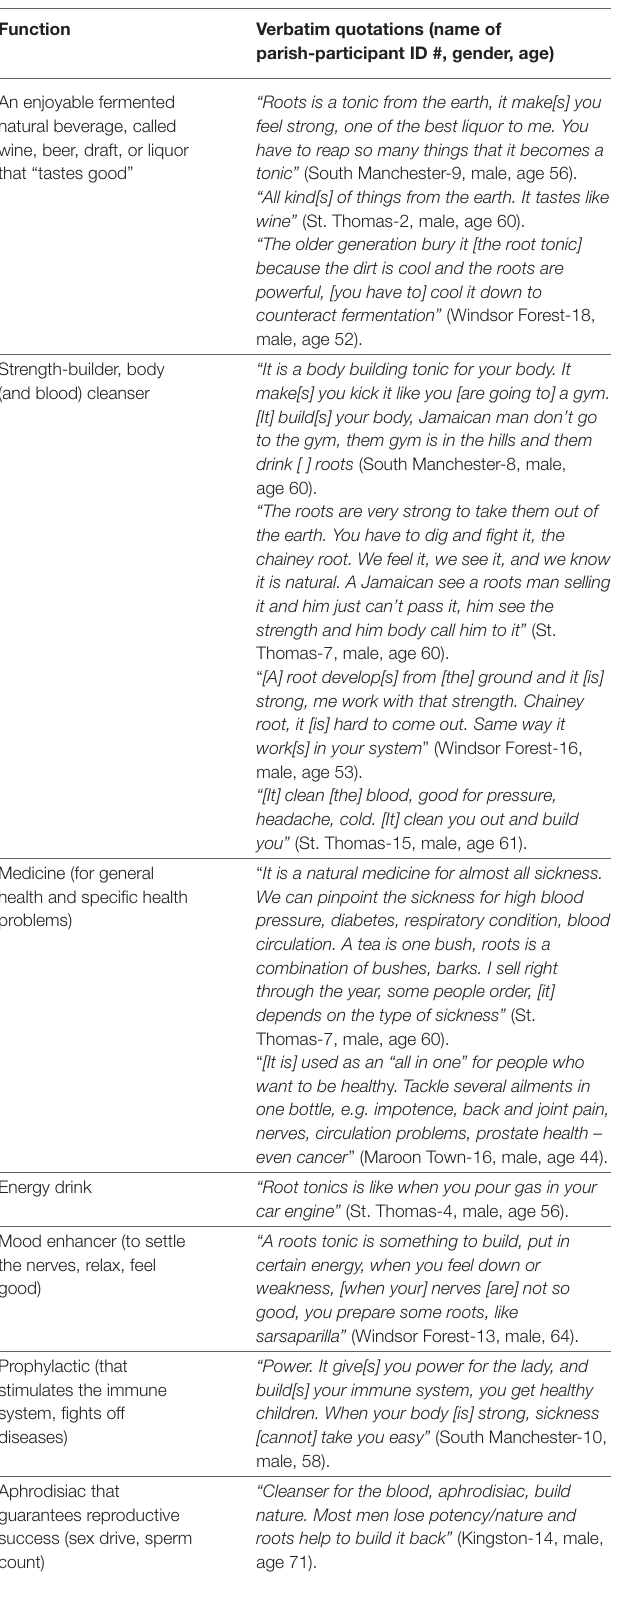
TABLE 3 | Complementary and/or overlapping functions of root tonics, and relevant associated quotations selected from interviews with 99 Jamaicans in five